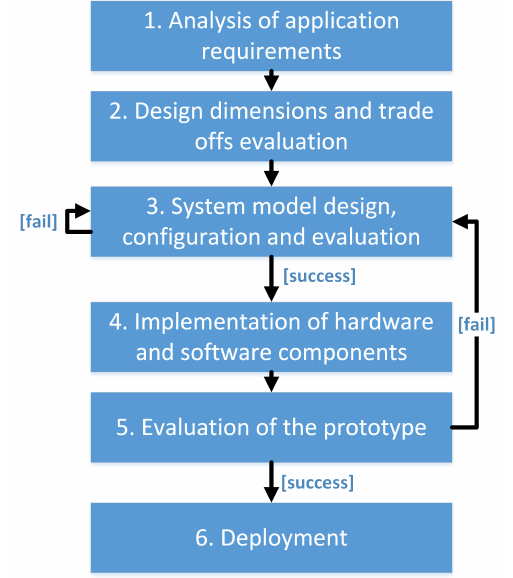
Figure 1. Traditional design flow for a wireless sensor node (based on methodology presented in Ref.